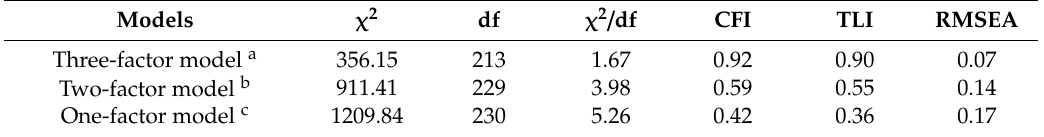
Table 3. Model fits of measurement models.